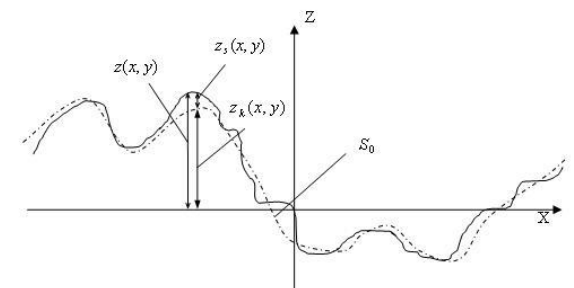
Fig.1 The decompose of two-scale roughness surface, the solid line represents the surface of z ( x , y ), and the dotted line S 0 is the large-scale surface ( z k ( x , y )) in X-Z